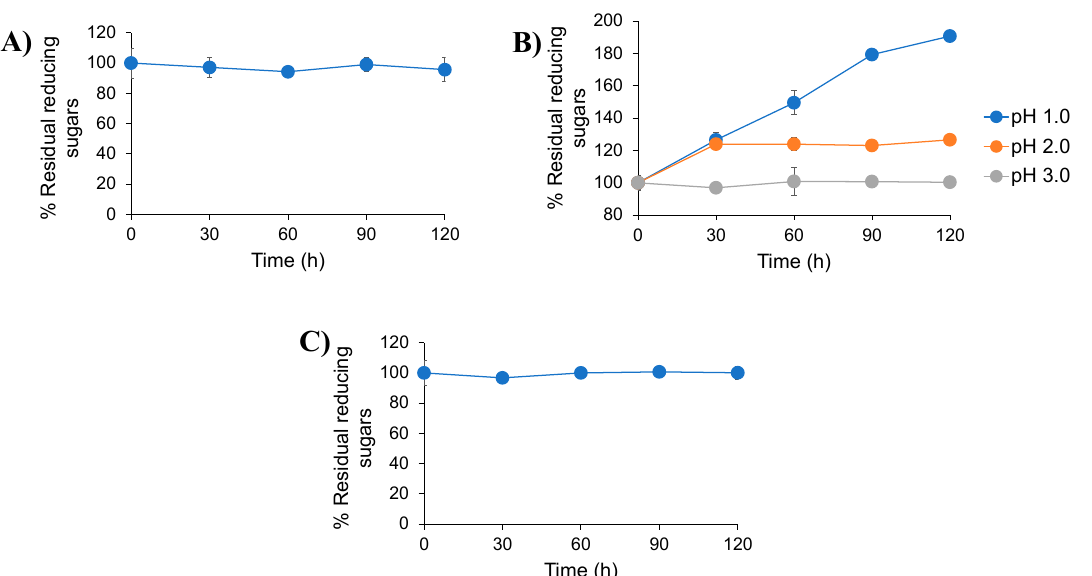
Figure 1. Residual reducing sugars retained after treatment of inulin-FOSs extract with simulated oral ( A ), gastric ( B ) and intestinal ( C ) conditions.